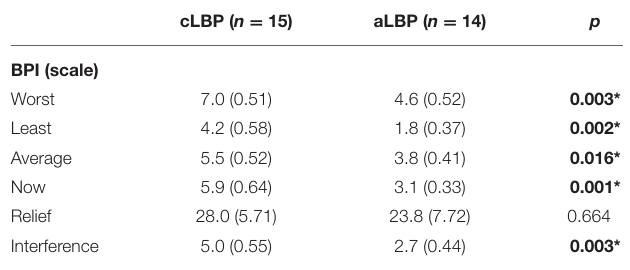
TABLE 1 | Demographic characteristics of study participants. TABLE 2 | Pain self-report at the time of low back pain onset by